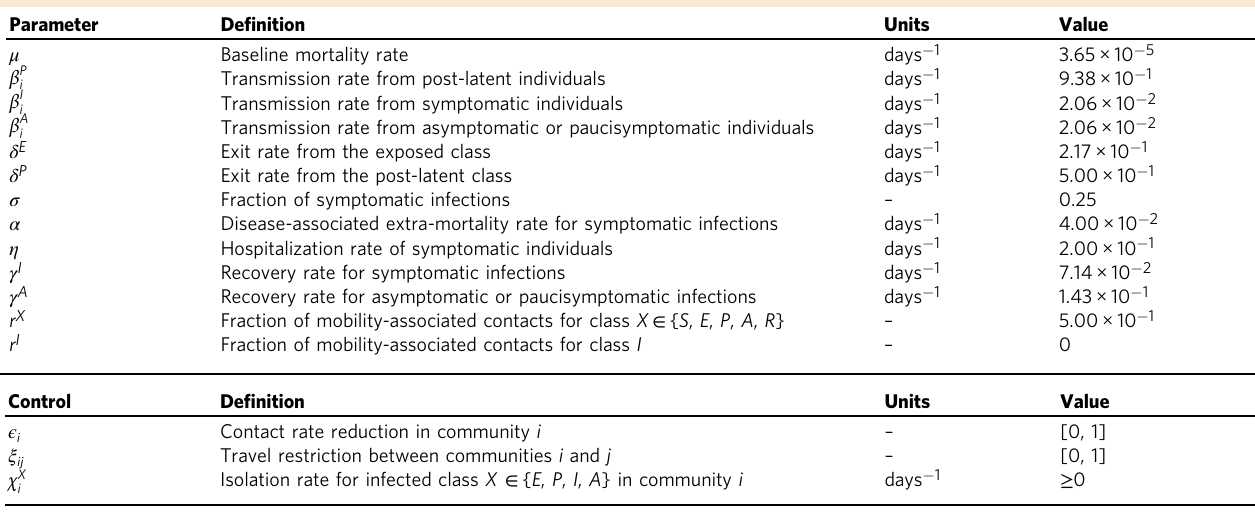
Table 2 Parameters and controls of model (Eq. (3)).